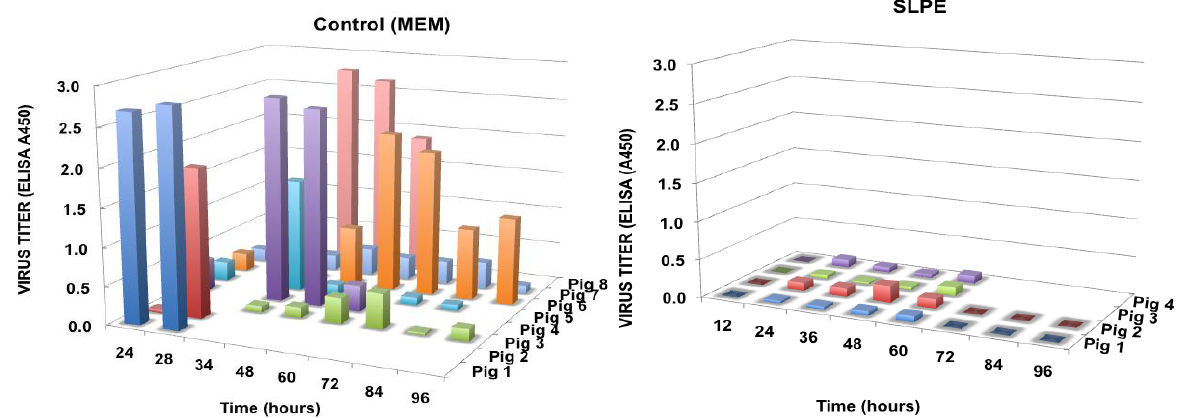
Figure 8. Effect of feeding SLPE (2 µmol) every 12 h on virus shedding in rotavirus inoculated piglets. Piglets were inoculated with rotavirus (1 × 10 5 FFU) in the presence or absence of SLPE fed every 12 h, and virus titers in feces collected at the indicated times determined as described in the Experimental